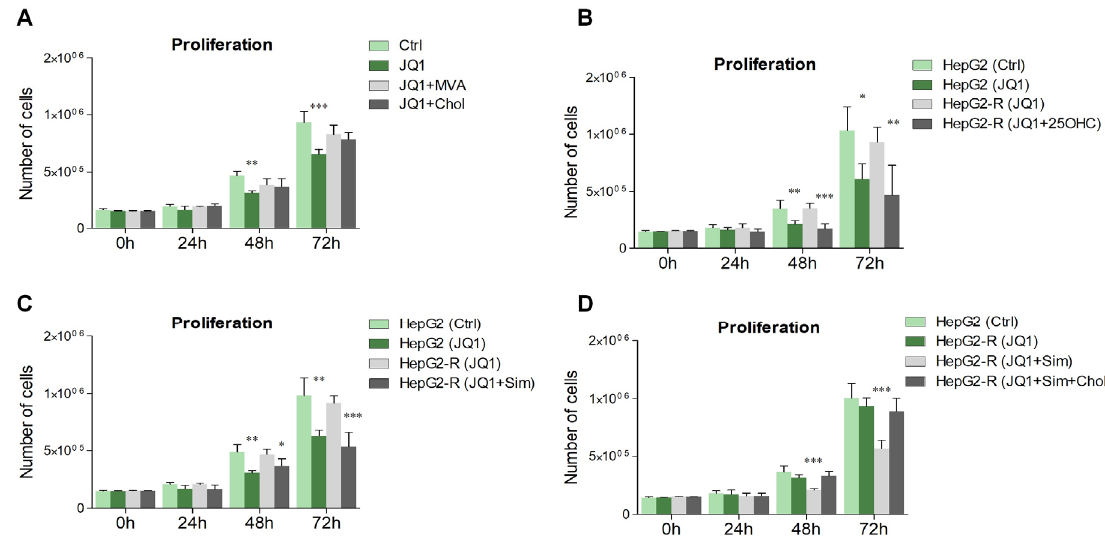
Figure 6. BET inhibition influences cell proliferation through cholesterol metabolism. ( A ) HepG2 cells were seeded in 6-well plates (150,000 cells for each well) and were treated with JQ1 (0.4 µ M), mevalonate (MVA, 100 µ M) and cholesterol (chol, 50 µ M) for 72 hours. Cell counts were conducted over time with a hemocytometer. ( B–C ) Cell proliferation was evaluated in JQ1-sensitive (HepG2) and JQ1-resistant (HepG2-R) cells. JQ1-resistant and -sensitive HepG2 cells were treated with the BET inhibitor for 72 hours, and additional groups of HepG2-R cells were co-stimulated with JQ1 + 25-hydroxycholesterol (25OHC, 20 µ M) or JQ1 + simvastatin (Sim, 1 µ M). Other cells were treated with vehicle and served as control (Ctrl). ( D ) Cell proliferation was evaluated in JQ1-sensitive (HepG2) and JQ1-resistant (HepG2-R) cells. JQ1-resistant cells were constantly stimulated with the BET inhibitor. Additional groups of HepG2-R cells were co-stimulated with JQ1 + simvastatin (Sim, 1 µ M) or JQ1 + Sim + cholesterol (Chol, 50 µ M). n = 4 independent experiments. Data represent means ± SD. Statistical analysis was assessed by using one-way ANOVA, followed by Dunnett’s post hoc. * p < 0.05; ** p < 0.01; *** p < 0.001.